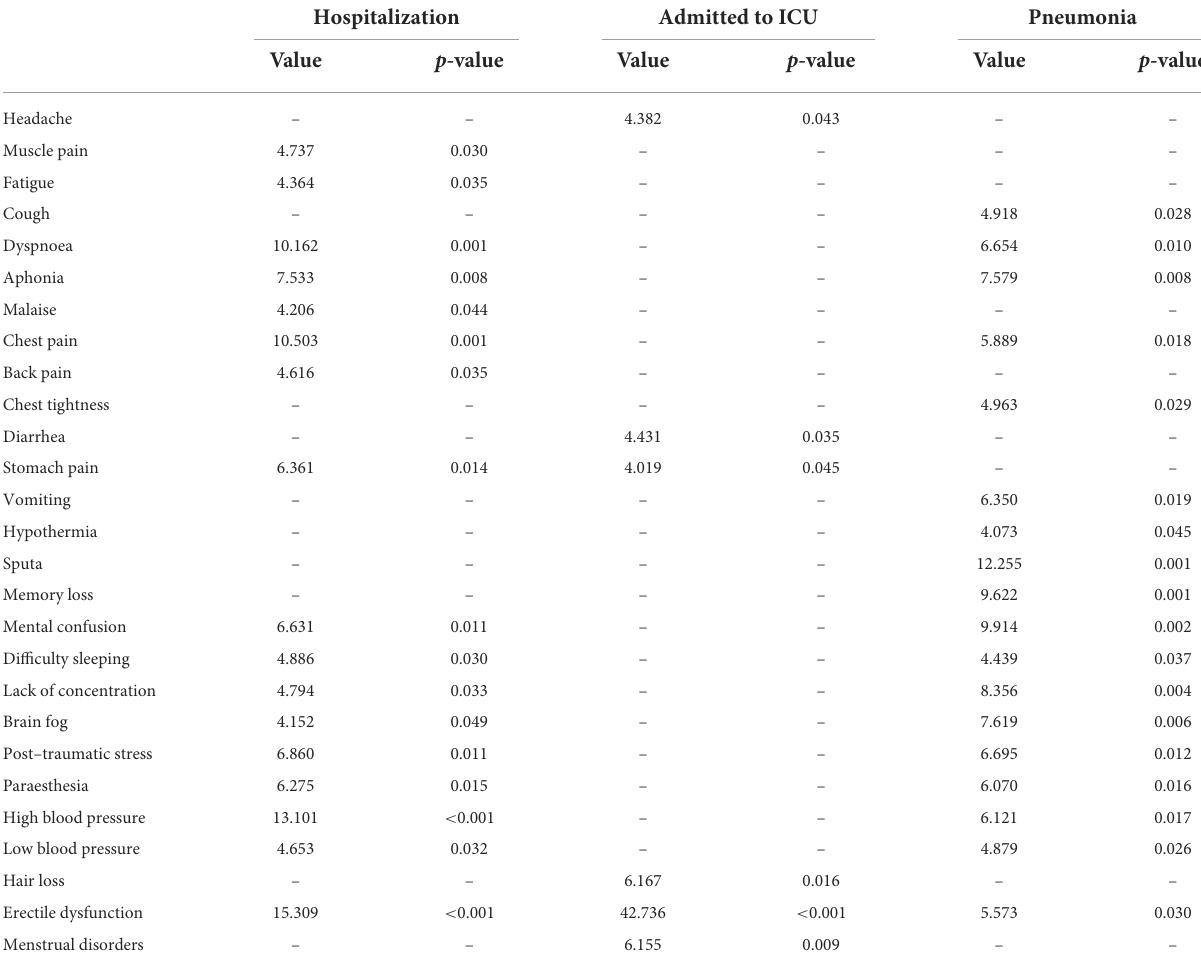
TABLE 1 Relationship between long COVID symptoms and hospitalization, ICU admission or